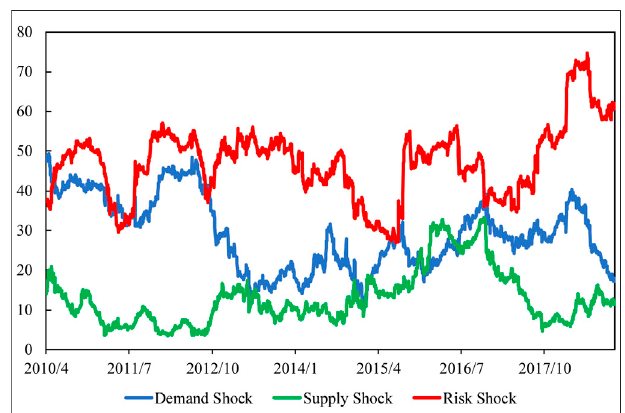
FIGURE 3 | Demand, supply and risk shocks connectedness over time (The rolling window is set to 200